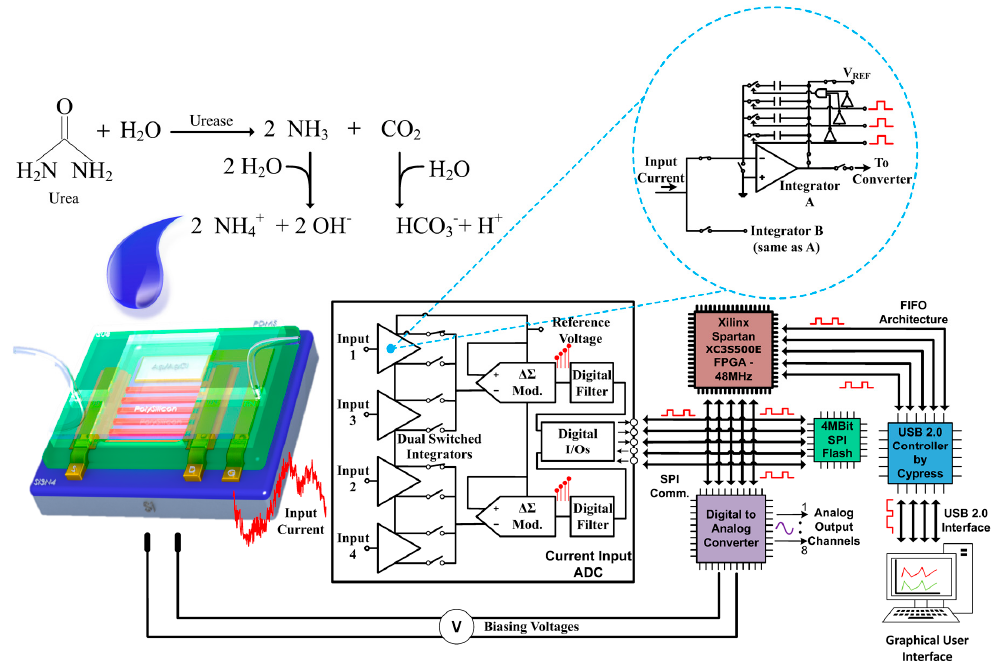
Figure A3. Schematic representation of the complete measurement setup.